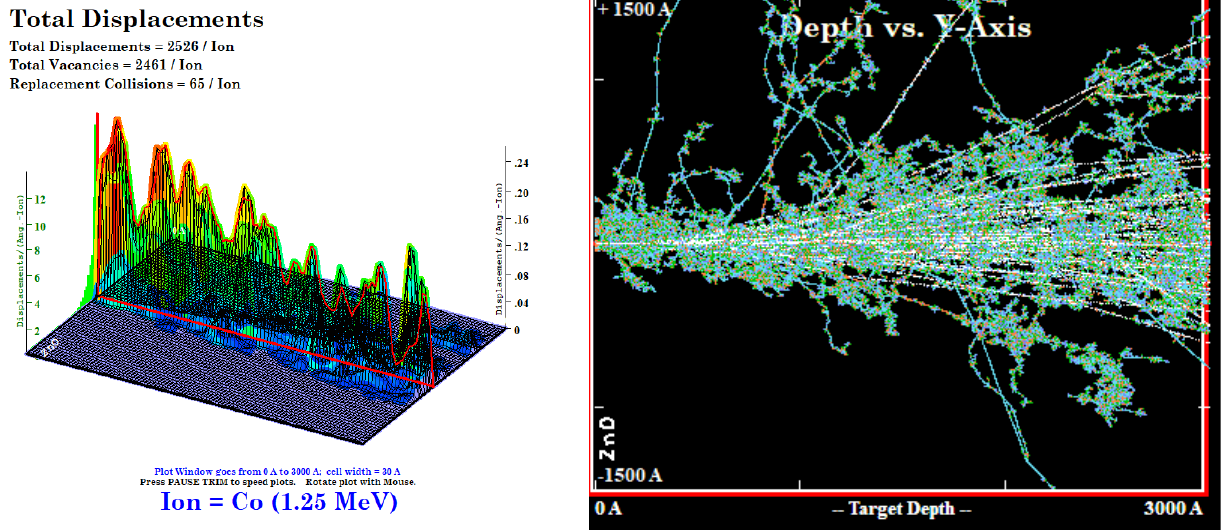
Figure 7. 3D plot of the total displacements and energy dispersion within the ZnO cell with the 1.25 MeV radiation.